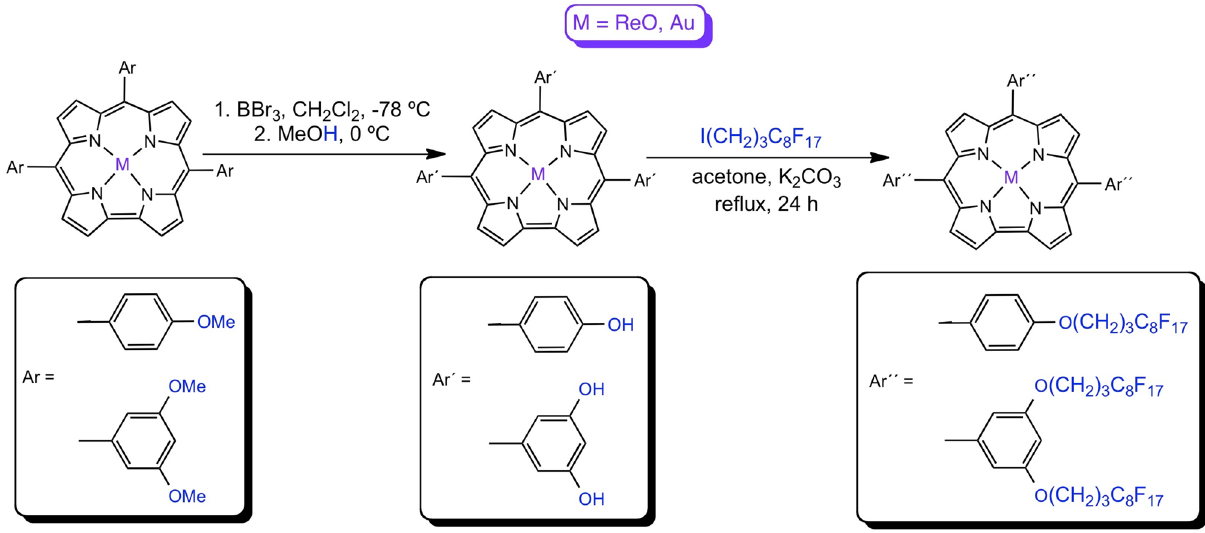
Figure 1. Schematic illustration of the synthesis of phenol- and resorcinol-appended metallocorroles and their derivatization with a fluorous tag.